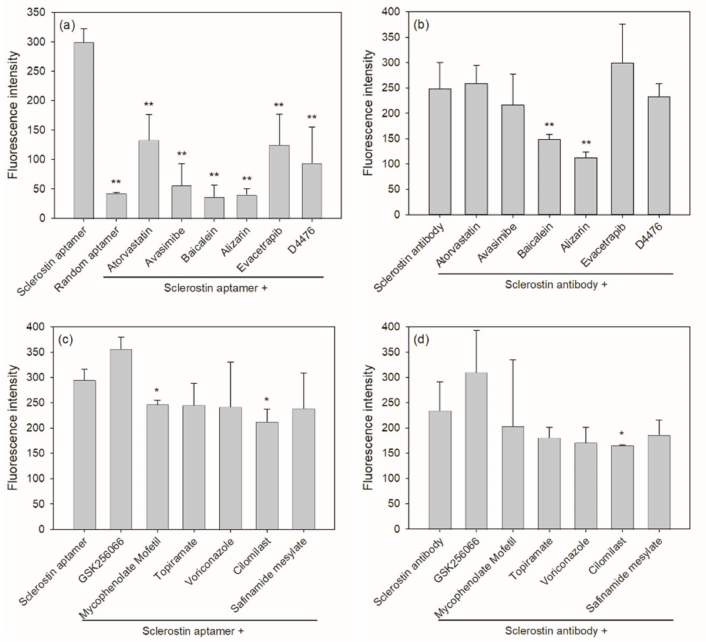
Figure 3. Fluorescence intensity of the sclerostin-specific aptamer or the sclerostin antigen–antibody immunocomplex in the presence of selected small-molecule inhibitors. His-tagged sclerostin protein was immobilized at 200 ng/well in a nickel-coated 96-well black plate and reacted with ( a , c ) 500 nM FAM-labeled sclerostin-specific aptamer in the presence or absence of 20 µ M of one of the inhibitors, or ( b , d ) 0.52 µ g/mL anti-sclerostin antibody (dilution ratio 1:500) in the presence or absence of 200 µ M of one of the inhibitors, followed by detection with FITC-labeled secondary antibodies. Fluorescence intensity was determined by a TECAN Infinite 200 PRO F Nano + microplate reader at Ex485 nm/Em520 nm. Error bars represent standard deviations ( n ≥ 3). * p < 0.05 and ** p < 0.01, compared to the